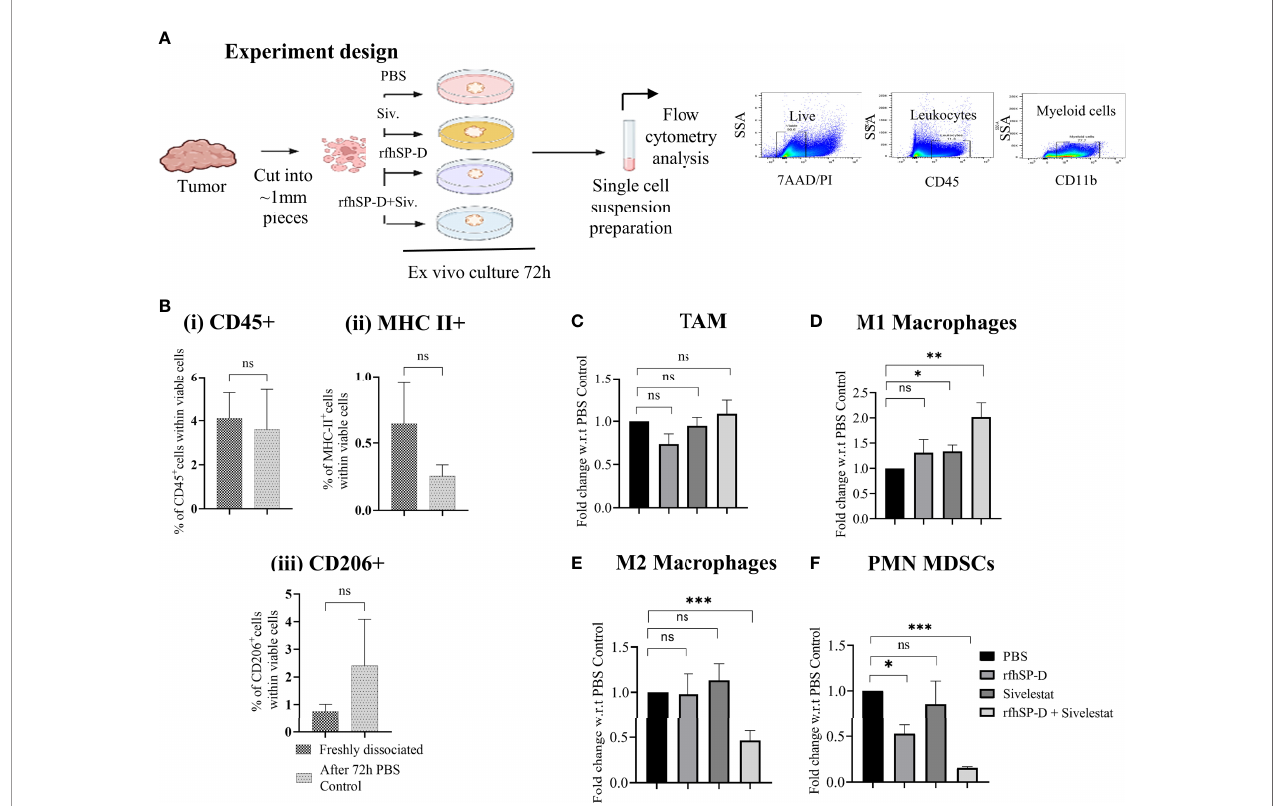
FIGURE 6 | Treatment with rfhSP-D+sivelestat induced polarisation of macrophages in ex vivo cultured TRAMP tumours. (A) Study design. (B) Comparison of (i) CD45+, (ii) MHC-II+ and (iii) CD206+ cells percentage between freshly dissociated TRAMP tumours and tumours after 72h culture in DMEM media. (C – F) Tumour tissues were collected from the late TRAMP and cultured in the serum-free DMEM with PBS/rfhSP-D/sivelestat/rfhSP-D+sivelestat treatment for 72h. After treatment, single cell suspensions were prepared and percentages of different immune cell types were analysed by fl ow cytometry. Fold change of (C) tumour-associated macrophages (TAM), (D) M1; (E) M2 and, (F) PMN-MDSCs in ex vivo cultured TRAMP tumours were calculated with respect to PBS control. n=3/treatment group. Data represented as mean ± SEM. Statistical signi fi cance was determined by the two-tailed Student ’ s t-test. (*p < 0.05, **p < 0.01, ***p < 0.001); ns, Non-signi fi